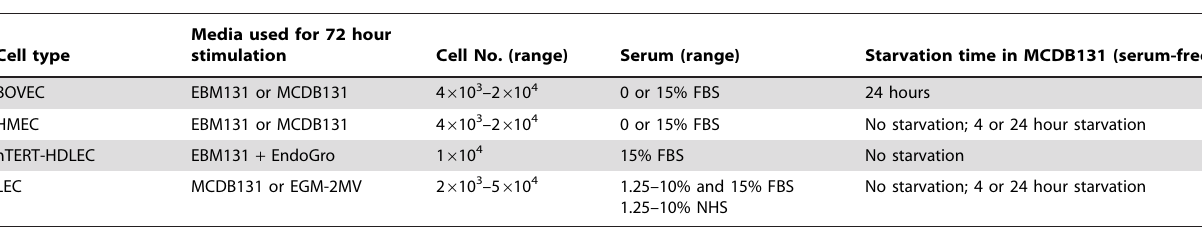
Table 1. In vitro cell culture conditions for EC proliferation